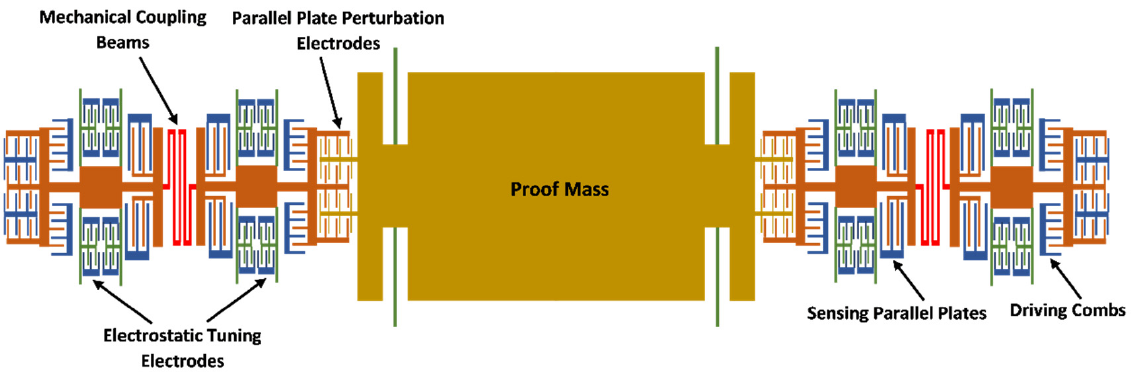
Figure 16. The structural design of mode-localized MEMS accelerometer with two sets of 2-DoF weakly coupled resonators on either side of central proof mass.